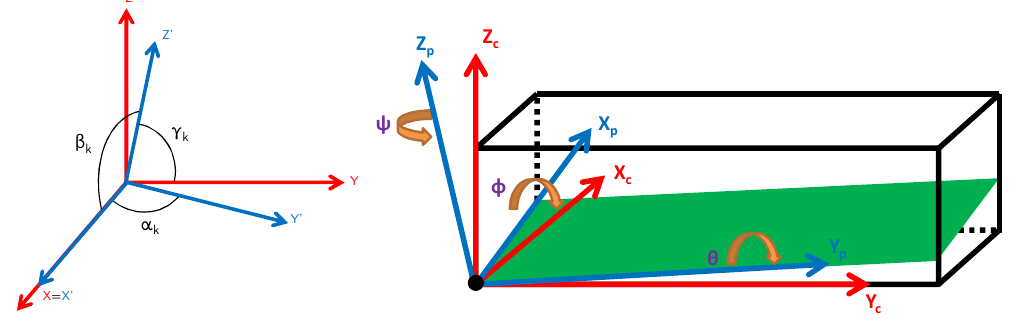
Figure 2. Representation of a non-orthogonal sensor triplet ( left ) and representation of a misaligned circuit board with respect to the IMU’s external box ( right